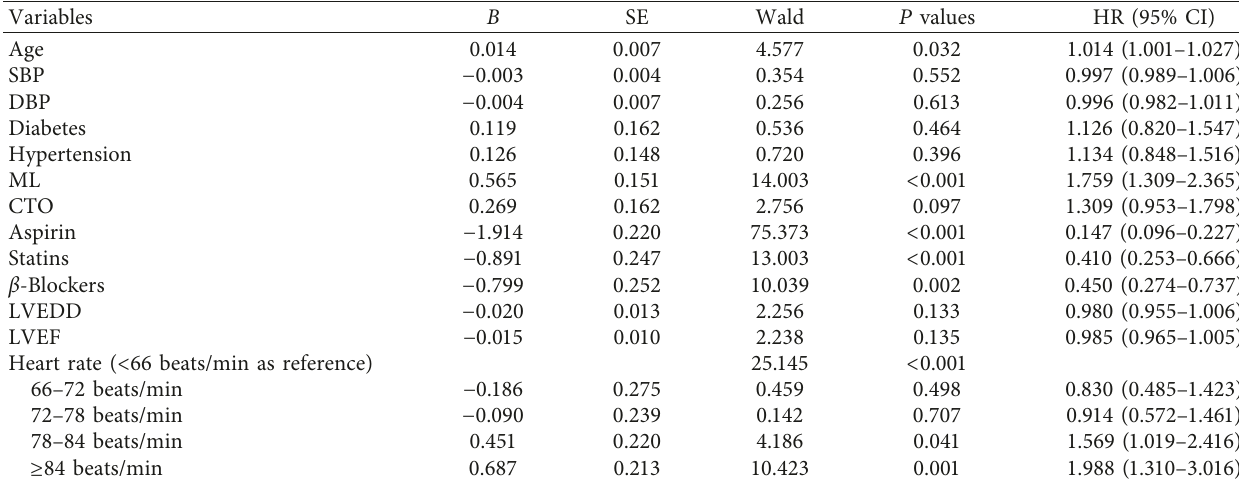
Table 4: Multivariable Cox regression analysis of